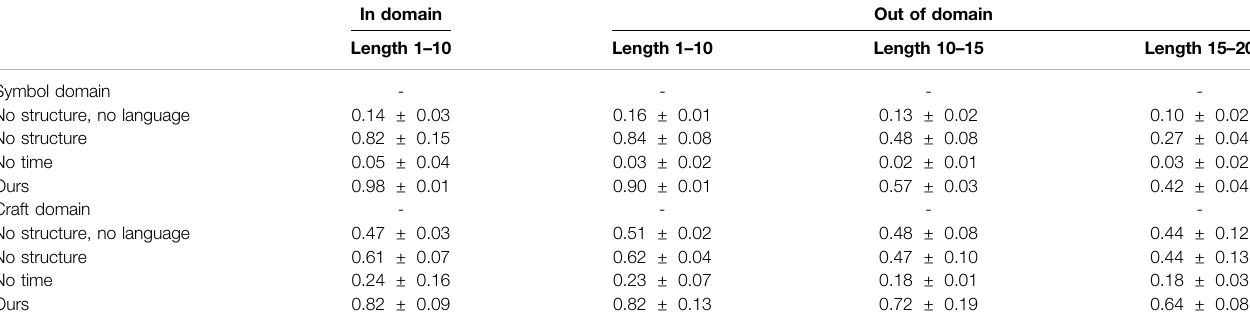
TABLE 2 | The performance of our model fi nding satisfying actions for LTL formulas. Each column summarizes the average success rate and standard deviation over three runs for each test set. In